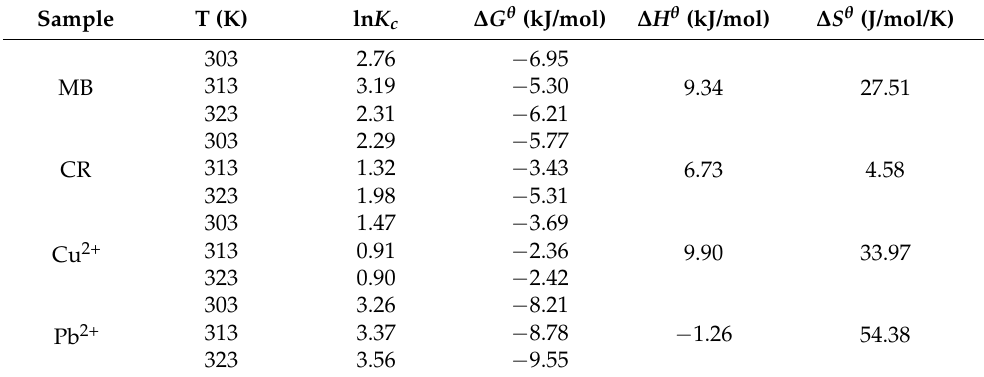
Table 4. Thermodynamic parameters for dyes and metal ions adsorption of UBC.